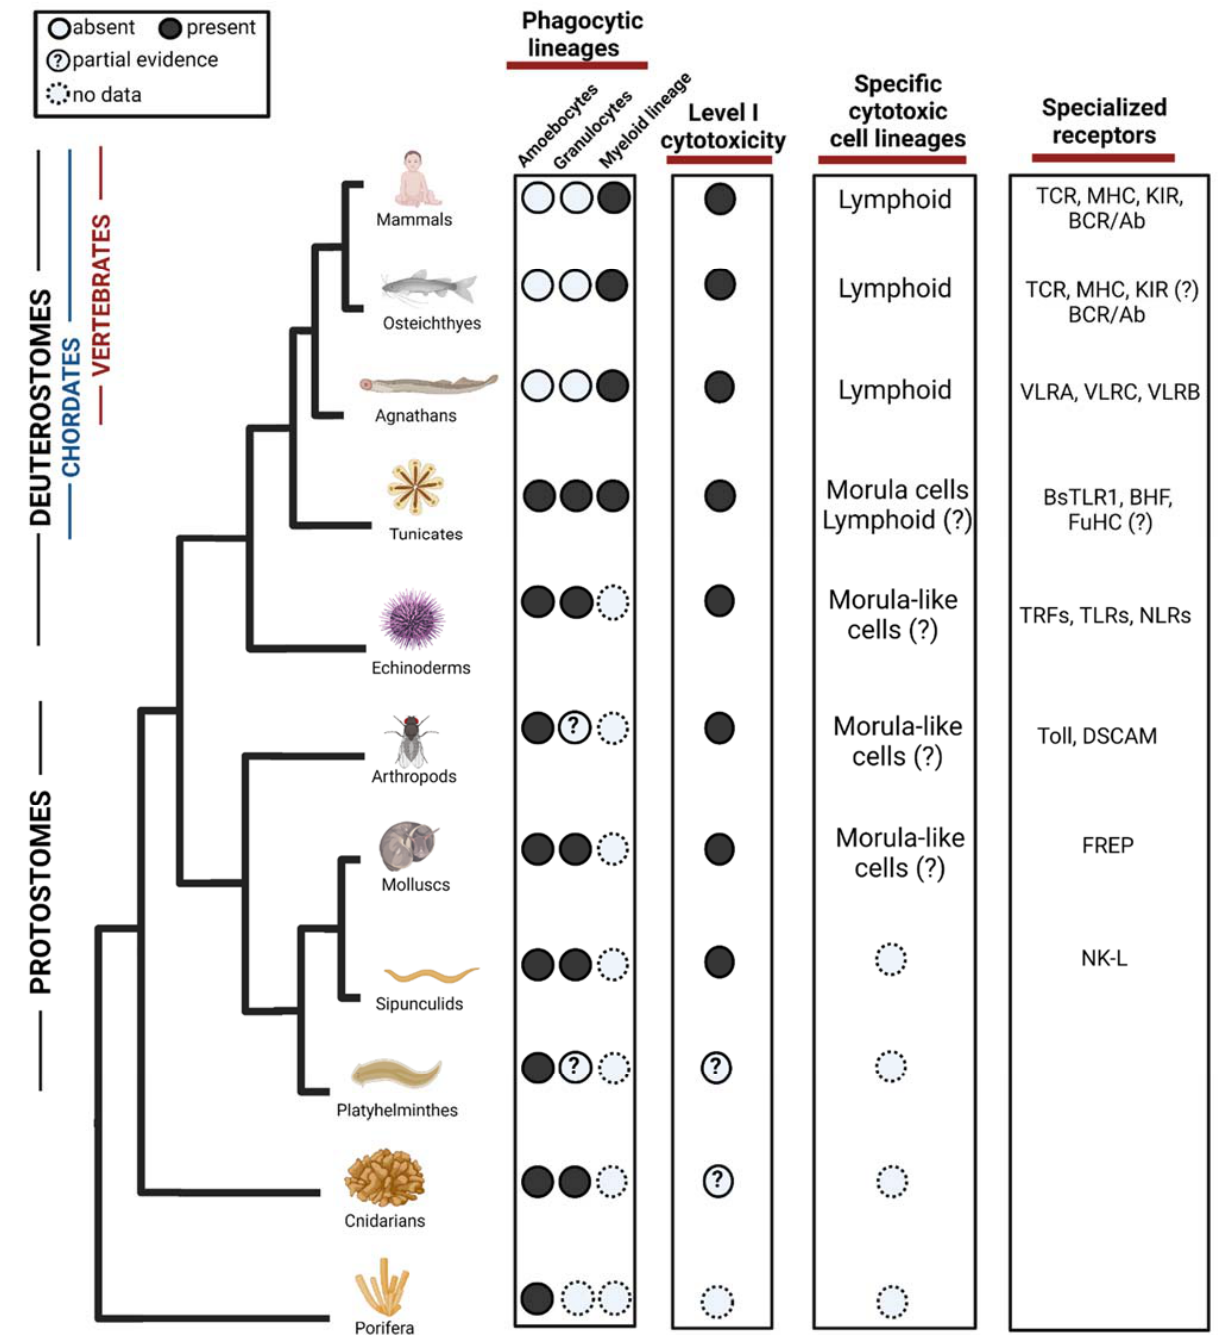
Figure 2. Evolution of phagocytic and cytotoxic cell lineages in the immune system. Among phagocytic lineages, amoebocytes and granulocytes are present in invertebrates, while myeloid lineage seems to evolve in the ancestor of tunicates and vertebrates. Cells representing the Level I cytotoxicity exist in Protostomes but might appear in cnidarian. Among specific cytotoxic cell lineages, morula cells have been found in tunicates although partial evidence suggests that they may evolve in earlier ancestors. Lymphoid cells are found in agnathans and have diversified in vertebrates, there are suggestions of their form in Tunicates but not validated yet. In the third column, we show examples of diversification of specialized receptors acting in both phagocytosis and cytotoxicity. TLR = Toll-like receptors, TCR = T-cell receptor, MHC = Major histocompatibility complex, KIR = Killer Inhibitory Receptors, BCR = B cell receptor, VLR = Variable lymphocyte receptor, BHF = Botryllus histocompatibility factor, TRF = Transformer proteins, NLR = NOD like receptors, DSCAM = Down syndrome cell adhesion molecule, FREP = Fibrinogen-related proteins, NK-L = Natural killer-like receptor. ?—Represents missing functional or molecular validation. Created with BioRender.com. Data sources are summarized in Table 1.